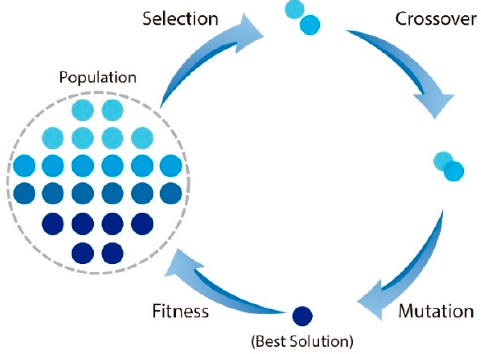
Figure 5. Cycle of the genetic algorithm.